Question: What direction does the quantity move in — increasing or decreasing?
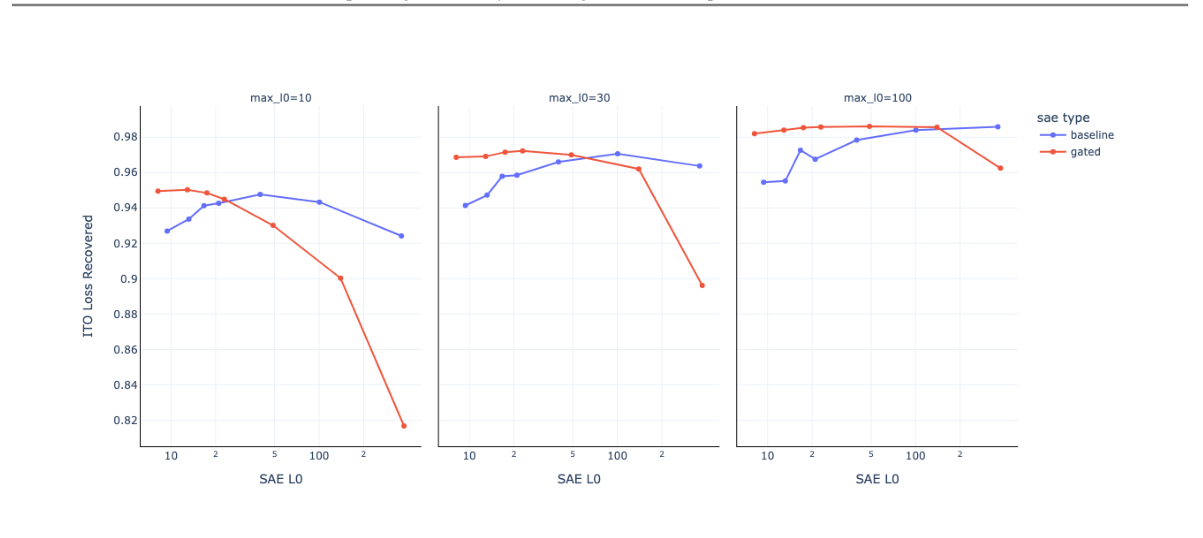
Answer: increasing